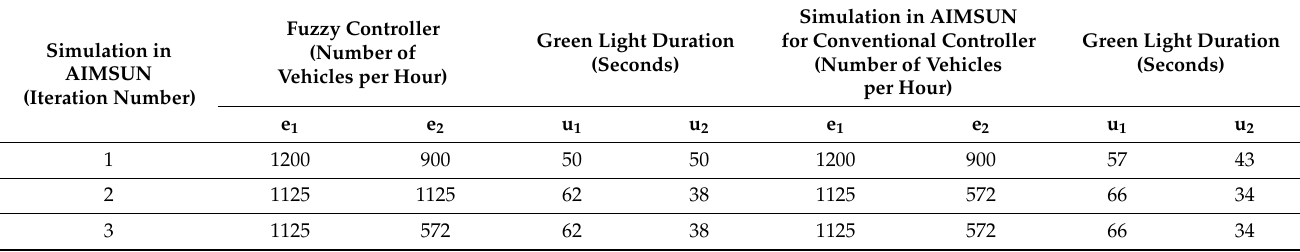
Table 1. Results of traffic simulation for junction